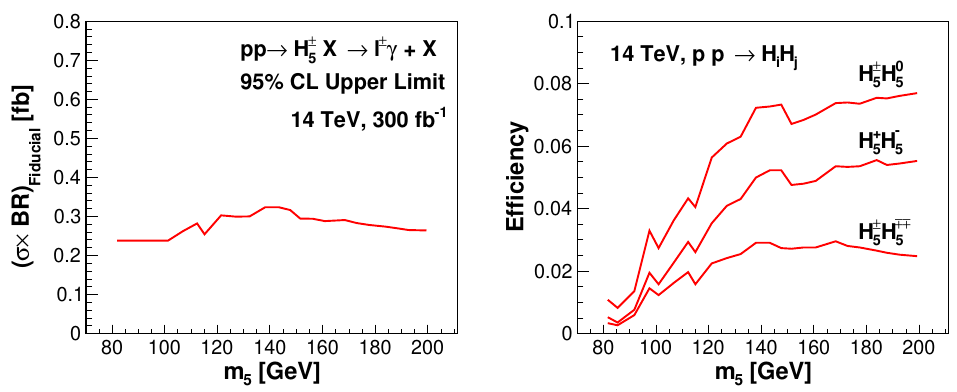
Figure 7 . The projected 95% con(cid:12)dence level (CL) upper limit on ( (cid:27) data at the 14 TeV LHC (left panel) and the e(cid:14)ciency (cid:15) of the cuts that de(cid:12)ne the (cid:12)ducial volume for each signal process (right panel).